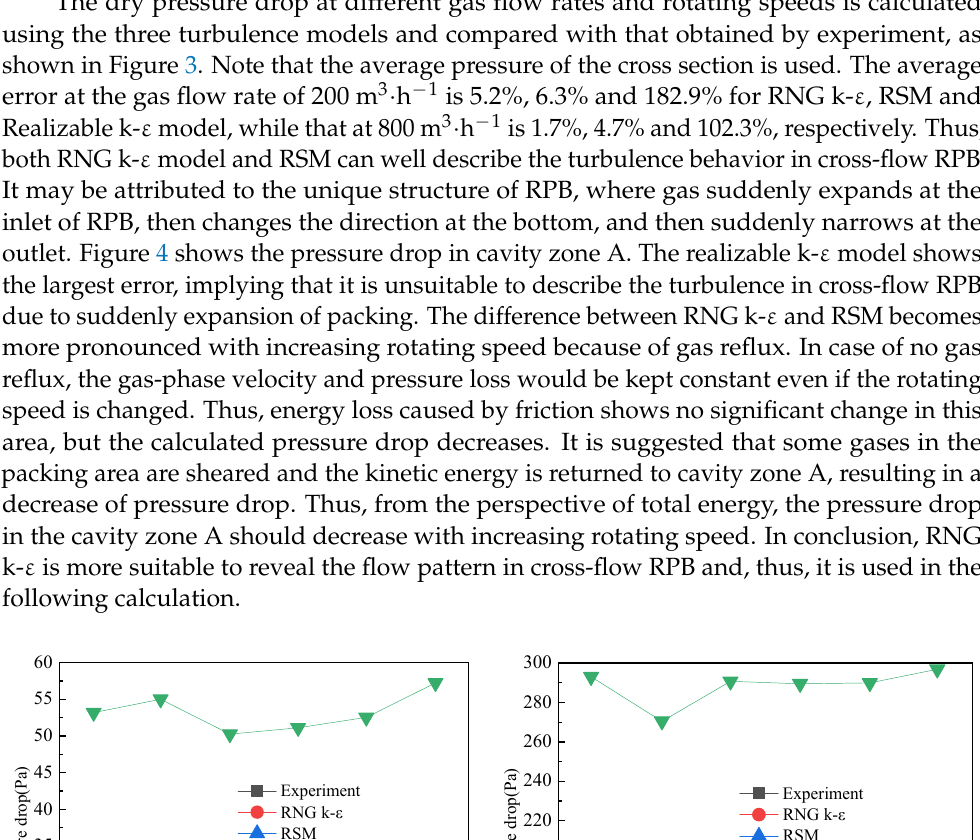
( b ) Figure 4. The pressure drop in cavity zone A for three turbulence models at different rotating speeds. ( a ) Gas flow rate of 200 m 3 ·h − 1 ; ( b ) gas flow rate of 800 m 3 ·h − 1 . 4.2. Cavity Zone A 4.2.1. Effect of Rotating Speed The rotating speed has significant effects on the pressure drop in cavity zone A, as shown in Figure 5. Figure 5a shows the pressure drop at the gas flow rate of 800 m 3 ·h − 1 decreases gently from 62.5 Pa to 38 Pa with the increase of rotating speed from 200 rpm to 1000 rpm, which is attributed to the gas reflux from the packing area to the cavity zone A. Figure 5b shows the effect of rotating speed on static pressure drop. Clearly, at a gas flow rate of 200 m 3 ·h − 1 and rotating speed below 400 rpm, the static pressure drop increases slowly from 2.5 Pa to 3 Pa and then more rapidly from 6 Pa to 20 Pa. A part of gas static energy is converted to internal energy and the rest is converted to dynamic pressure energy. At a gas flow rate of 800 m 3 ·h − 1 , the static pressure drop decreases from − 2.5 Pa to − 6 Pa, which may be due to the packing ‘block’, low gas velocity and conversion of dynamic pressure energy to static pressure energy. In order to learn more about pressure drop, plane a 2 (Figure 1b) is added. The static pressure drop between a 2 and a 3 changes greatly because the cross section is expanded suddenly at the inlet and thus a part of the static pressure energy is converted to internal energy and kinetic energy. While the static